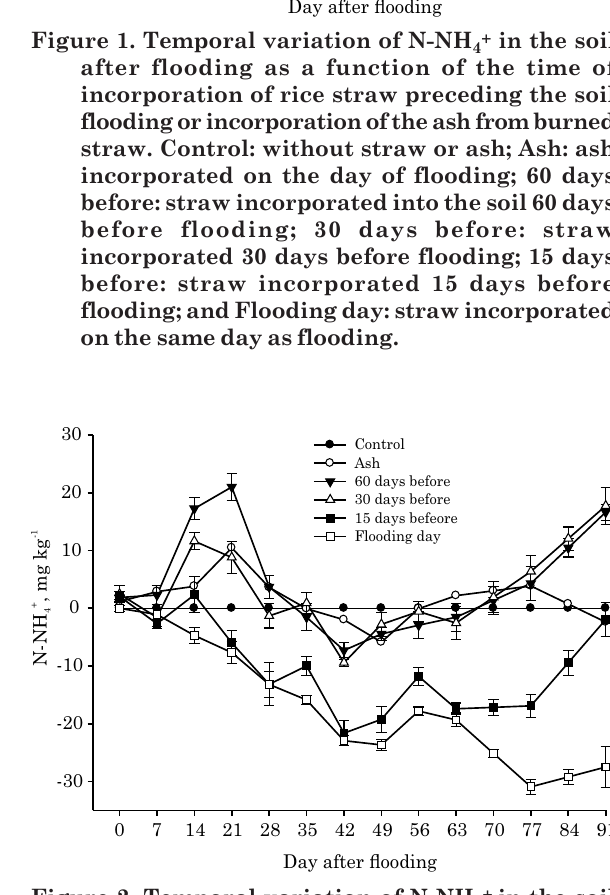
Figure 2. Temporal variation of N-NH 4 + in the soil after flooding as a function of the time of incorporation of rice straw after being substracted the values of the control treatments. Control: without straw or ash; Ash: ash